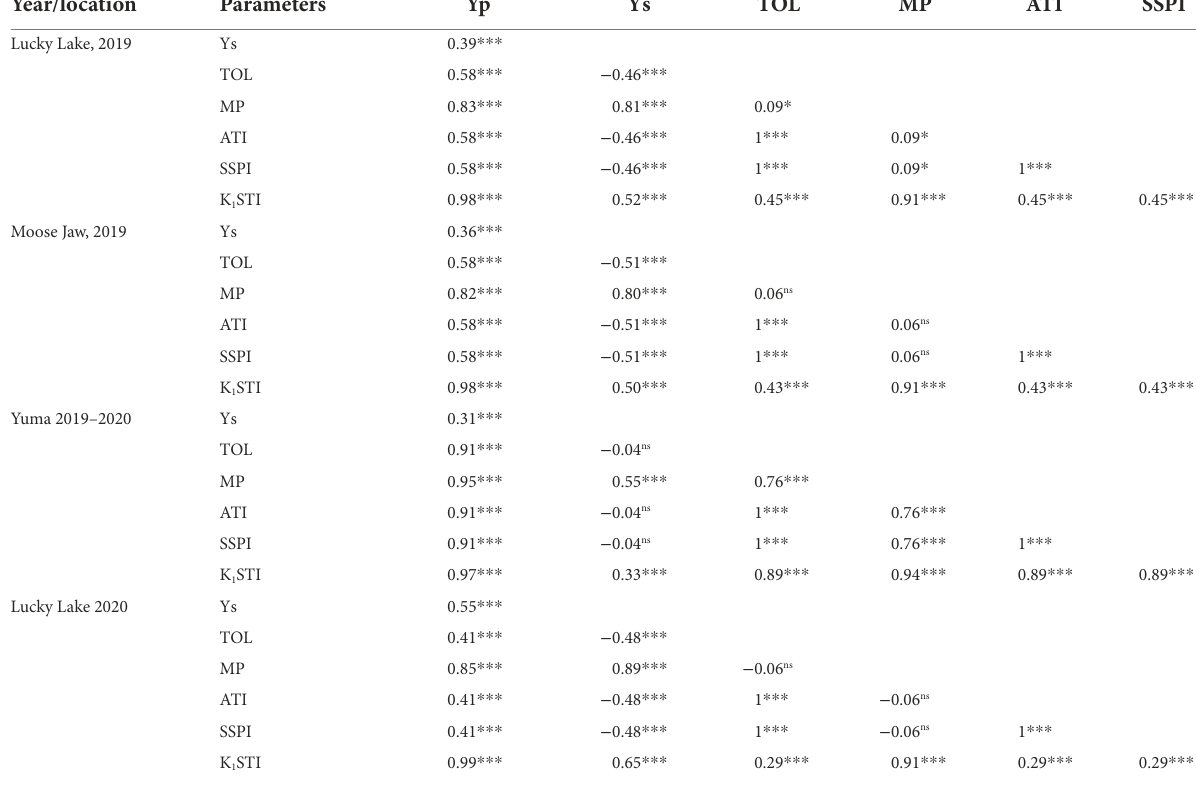
TABLE 3 Spearmen’s rank correlation between different stress tolerance indices for each site